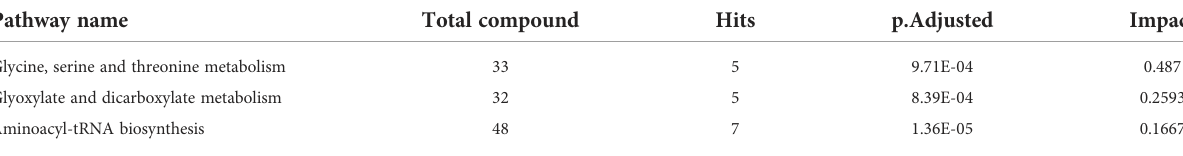
TABLE 6 Metabolic pathway enrichment for IPFD WPI metabolome response model. Pathway